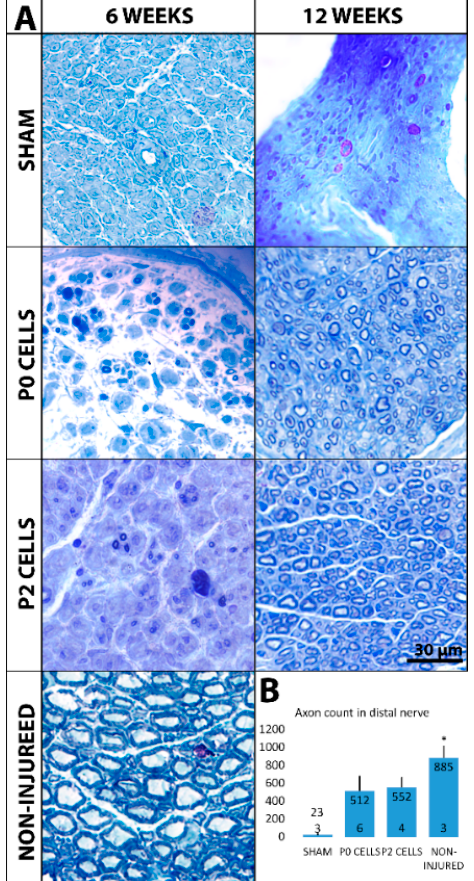
Figure 5. ( A ) Semithin musculocutaneous nerve cross-sections, from sections close to the muscle and distal to the cell graft, stained with toluidine blue show myelinated axons 6 and 12 weeks after the injury. In sham group only very few or no myelinated axons can be seen after 6 and 12 weeks. In cell-grafted nerves, some small, thinly myelinated axons can be seen after 6 weeks, and by 12 weeks, the nerves are fully filled with small thinly myelinated axons. Big myelinated axons from non-injured nerve are shown for comparison; ( B ) The total number of axons in each group is expressed as mean + SEM. Statistical difference is shown versus Sham. * p < 0.05. The number of animals in each group is shown inside the bar base.